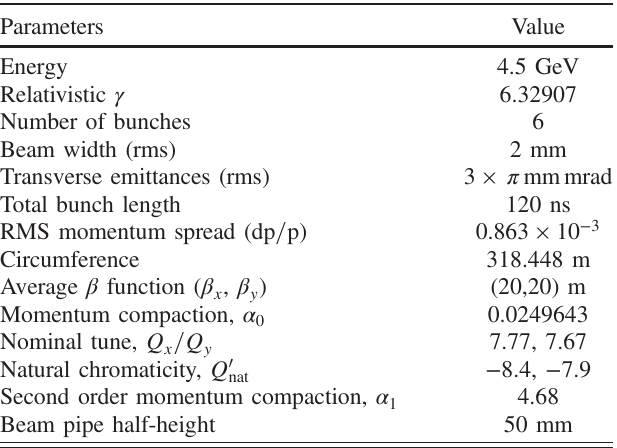
TABLE II. Parameters of the accumulator [19].